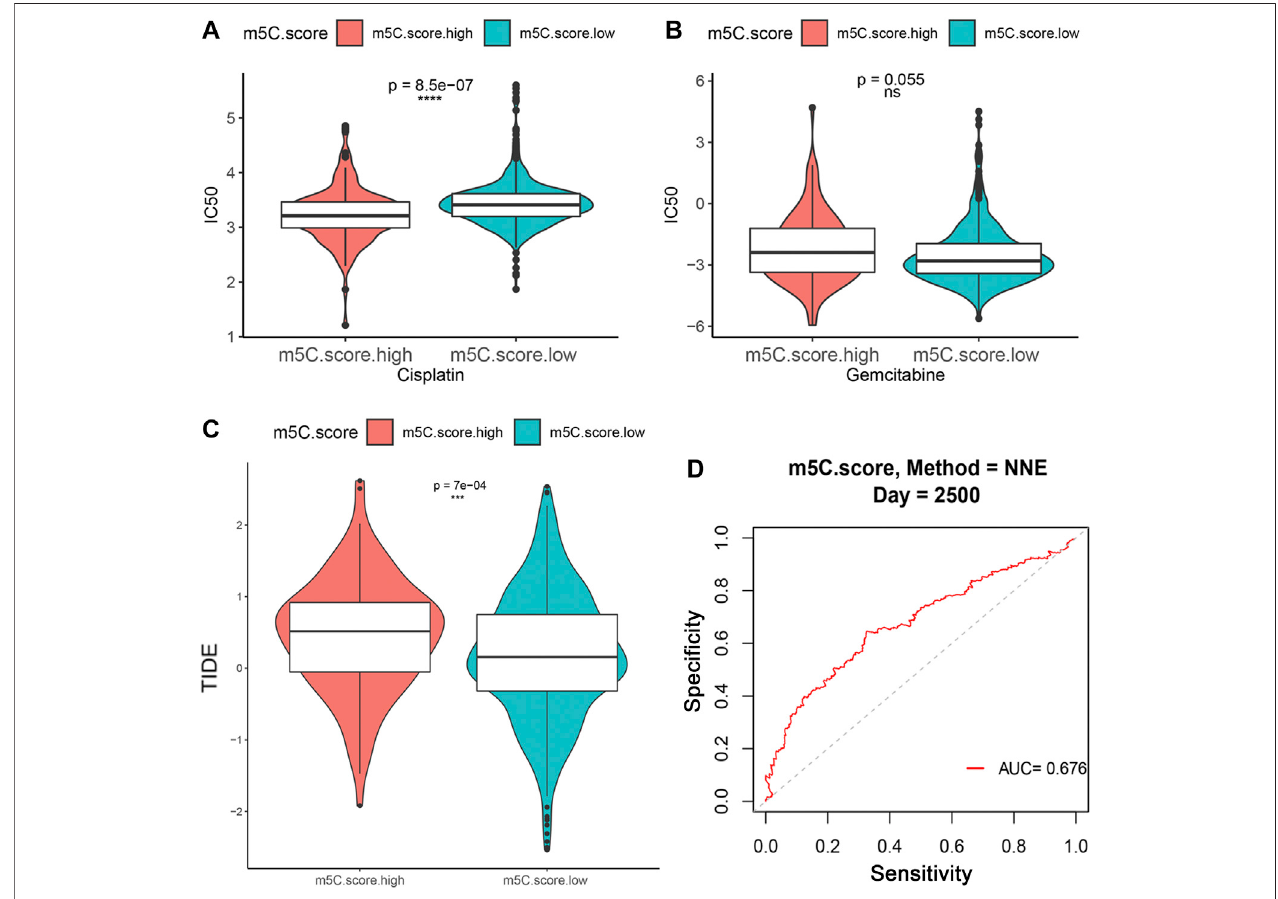
FIGURE9| In fl uenceofm 5 Cmodi fi cationpatternsonchemotherapyandimmunotherapyresponse. (A – B) IC50valueforcisplatinandgemcitabineinlowandhigh m 5 C score groups. (C) TIDE prediction score of low and high m 5 C score groups. (D) ROC curve for evaluating the ability of m 5 C score to predict immunotherapy response.